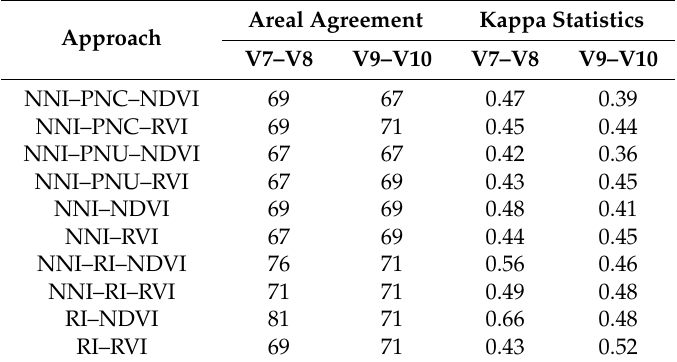
Table 7. Areal agreement and Kappa statistics for different N status diagnostic approaches at different growth stages across 2014 and